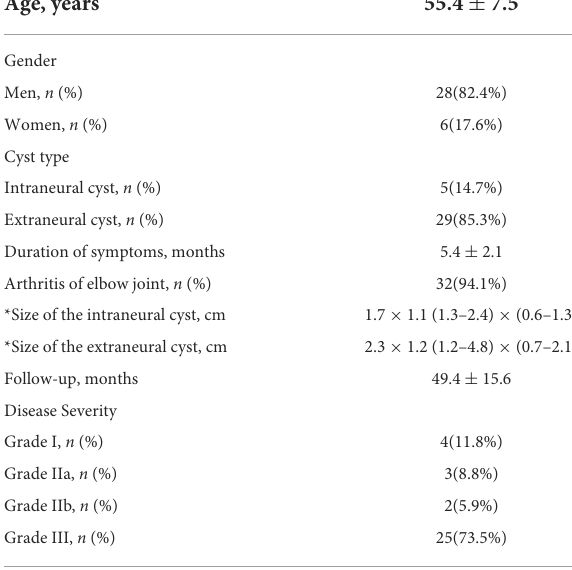
TABLE 1 Demographic data and clinical